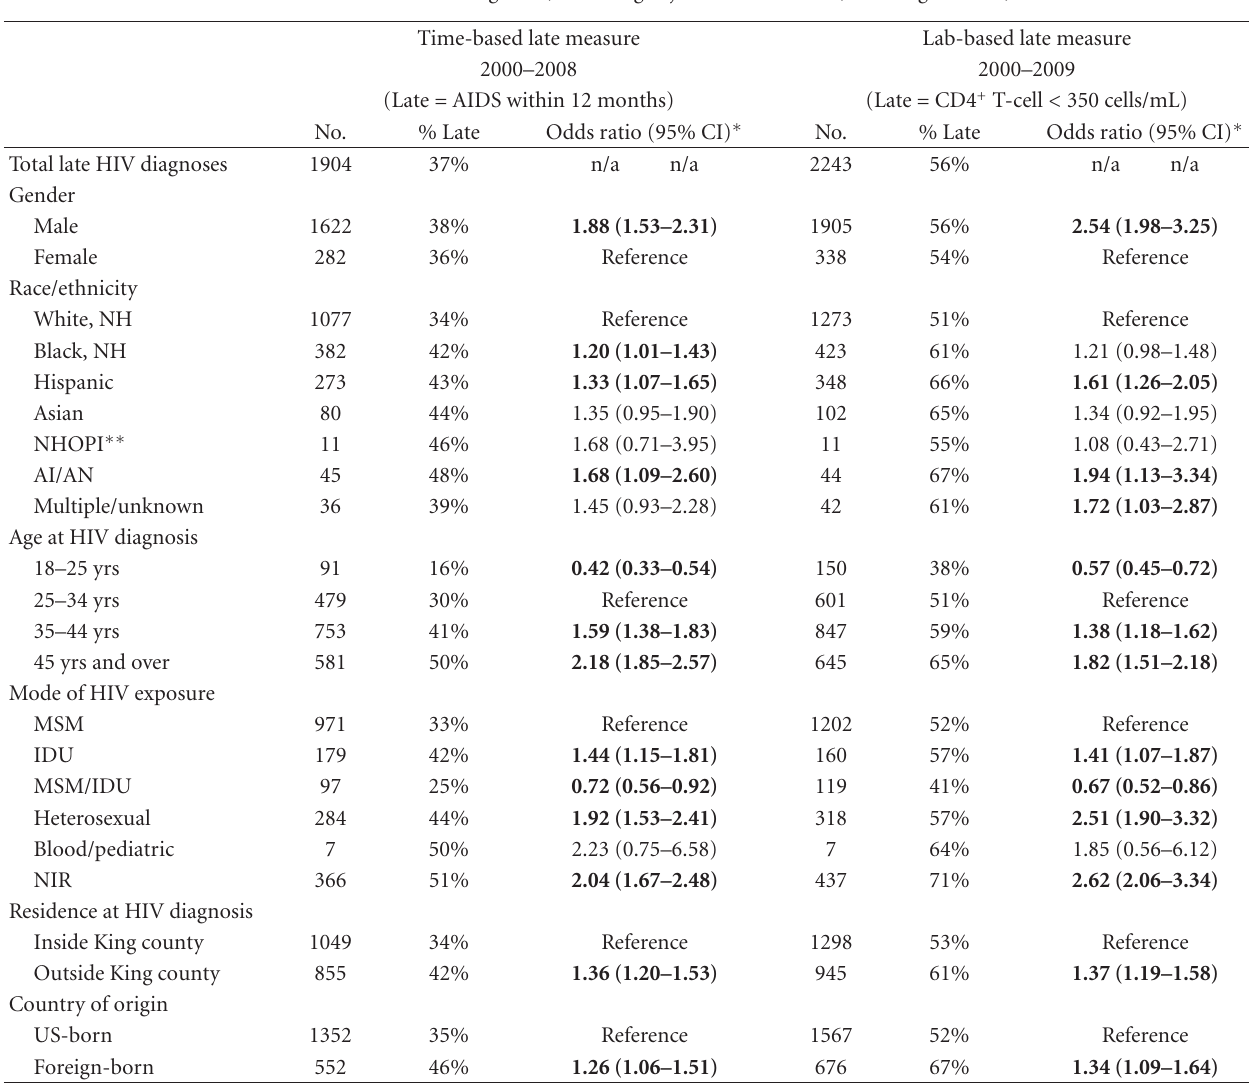
Table 2: Characteristics of late HIV diagnoses, including adjusted ∗ odds ratios, Washington state,